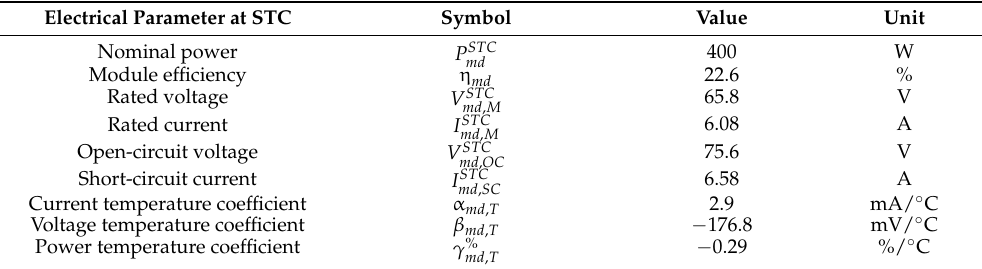
Table 1. Photovoltaic module technical specification.